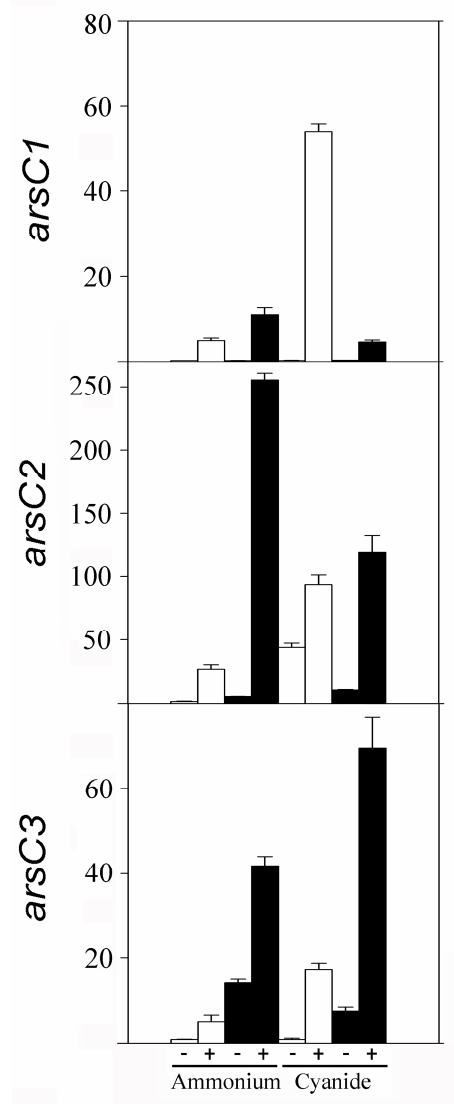
Figure 4. Relative expression of arsenate reductase genes ( arsC1 , arsC2 , and arsC3 ) of P. pseudoalcaligenes CECT 5344 in response to arsenic. Gene expression was analyzed by qRT-PCR in cells grown with 2 mM ammonium chloride or 2 mM sodium cyanide as the sole nitrogen source, without ( − ) or with (+) arsenite 0.25 mM (white bars) or arsenate 200 mM (black bars).